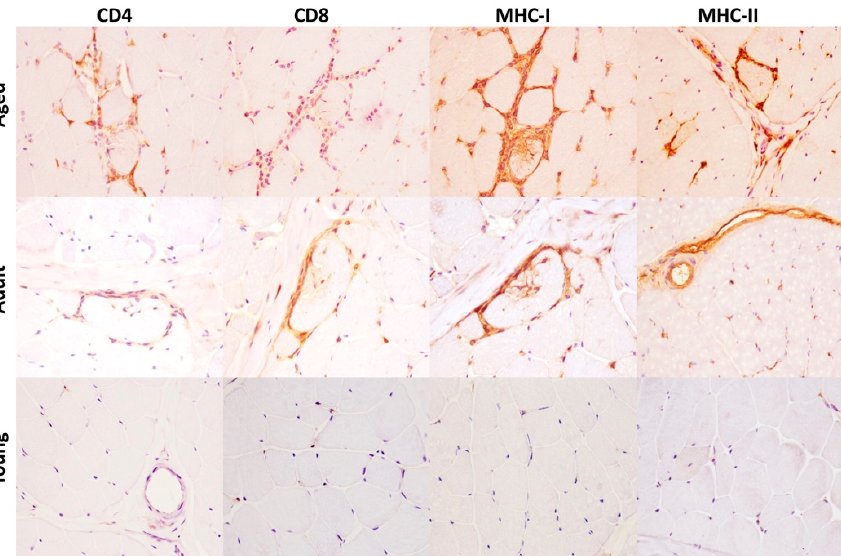
Figure 2. Immunohistochemical staining for CD4, CD8, MHC-I and MHC-II in skeletal muscle of aged, adult and young cows. Aged cows (Group A): there is a mild to moderate inflammatory infiltrate in the endomysium consisting mostly in CD8+, rare CD4+ T cells. Scattered muscle fibers show sarcolemmal immunolabeling for MHC-I and MHC-II antibodies. HRP method with Mayer’s hematoxylin counterstain. Adult cows (Group B): there is a mild inflammatory infiltrate in the endomysium consisting mostly in CD8+, rare CD4+ T cells. Scattered muscle fibers show sarcolemmal immunolabeling for MHC-I, but not for MHC-II antibody. HRP method with Mayer’s hematoxylin counterstain. Young cows (Group C): no inflammation is detectable and there is absence of MHC-I and MHC-II immunolabeling on muscle fibers. HRP method with Mayer’s haematoxylin counterstain.